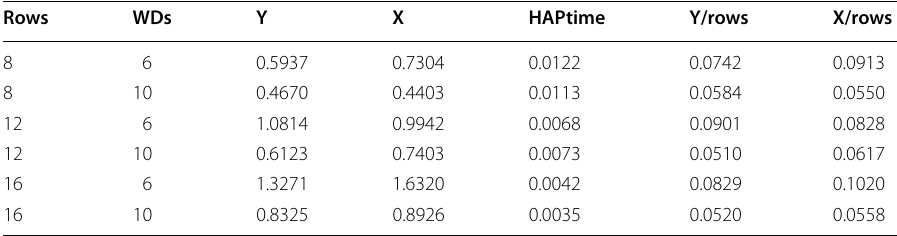
This table describes the standard deviation of some variables from the experimental results using test dataset, are same to as Table 3.